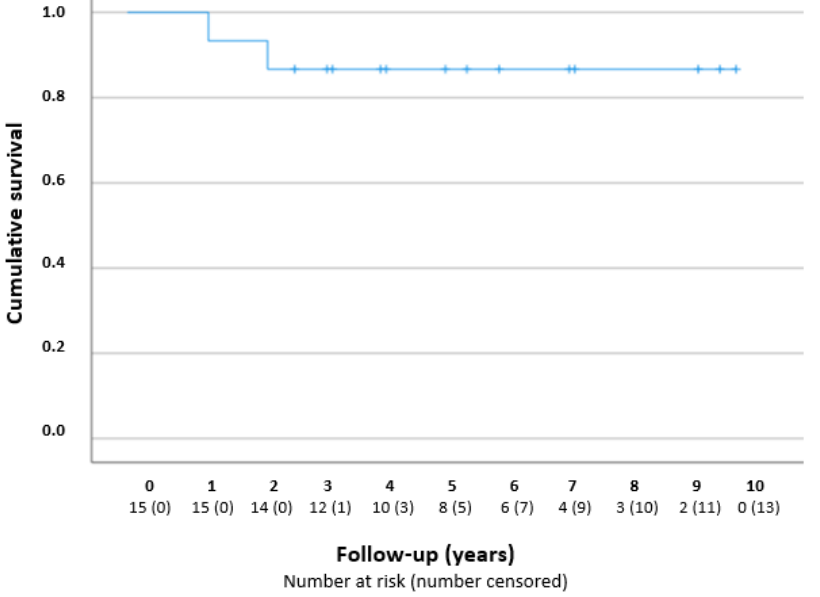
Figure 2. Kaplan–Meier curve—cumulative survival after one goniotomy procedure in years. The Figure 2. Kaplan – Meier curve — cumulative survival after one goniotomy procedure in years. The number at risk is reported per year during the follow-up. number at risk is reported per year during the